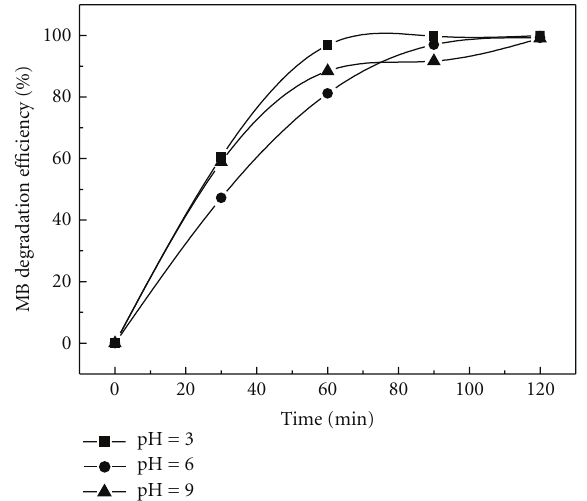
Figure 9: E ff ect of solution pH on photoelectrocatalytic degrada- tion of